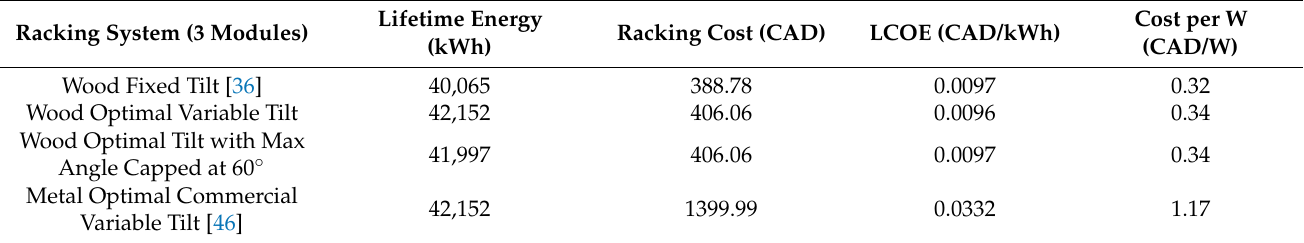
Table 7. Cost analysis of each racking system with a set of 3 PV modules of 400 W each, the total system installed DC power is 1200 W, assuming no construction labor costs.